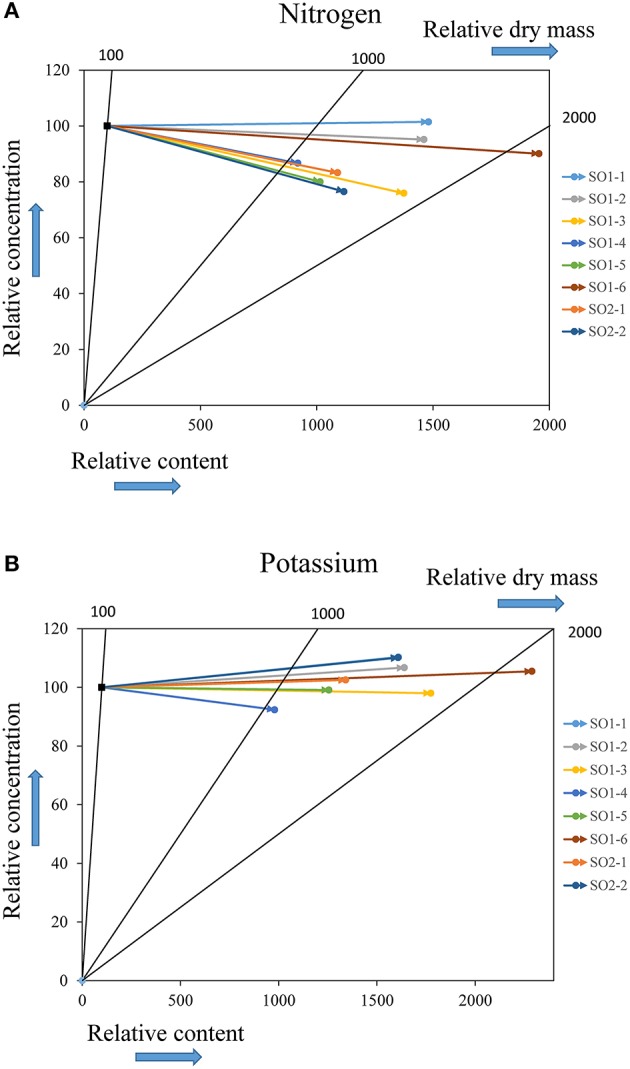
Vector analysis of the evolution of nutritional status for nitrogen (A) and potassium (B) in above-ground parts of seedlings from each seed orchard growing at the northerly site of Deville. The reference point (100) represents the initial characterization just before outplanting, whereas the final coordinates of each vector represent the nutritional status of seedlings from each seed orchard after four growing seasons on the planting site with respect to the reference point.